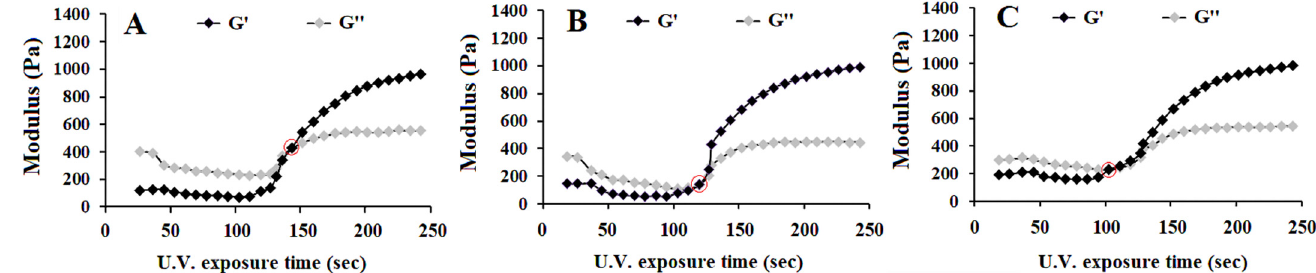
Figure 3. The effect of UV exposure time on the storage (G’) and loss (G”) moduli of 15 wt% SerAte- UM precursor solution with degree of modification of 24% ( A ), 31% ( B ), and 40% ( C ). The red circles show the gelation time at which G’ = G”.